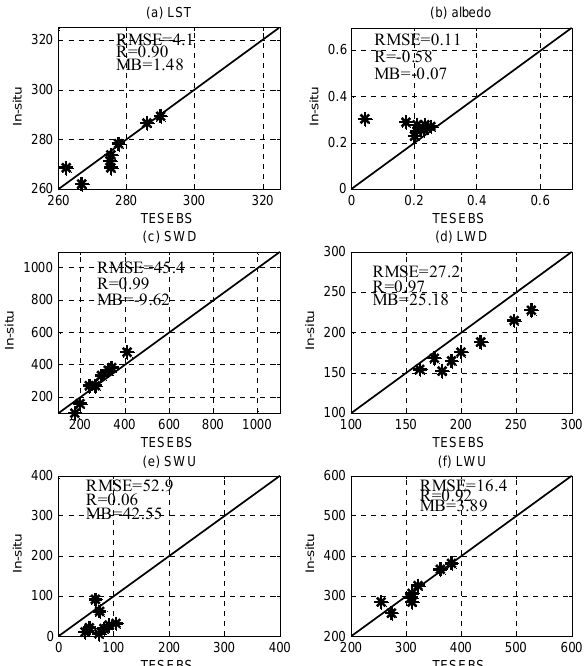
Fig. 3. Comparison of derived results with field measurements for the (a) land surface temperature (LST, unit K), (b) albedo, (c) downward shortwave radiation (SWD, unit Wm − 2 ) , (d) downward longwave radiation (LWD, unit Wm − 2 ) , (e) upward shortwave radiation (SWU, unit Wm − 2 ) , (f) upward longwave radiation (LWU, unit Wm − 2 ) .